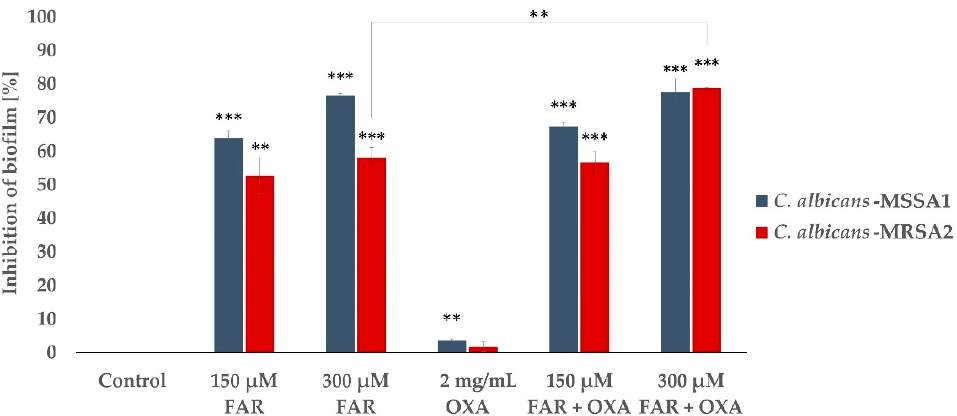
Figure 3. Inhibitory effect of FAR (150 and 300 µ M) in combination with OXA (2 mg/mL) on mixed biofilms formed by C. albicans -MSSA1 and C. albicans -MRSA2 using the XTT assay. Optical density (OD 490 ) of suspension was determined after 48 h cultivation of biofilms in the presence of different concentrations of FAR; the control sample was without FAR. Percentage of growth inhibition was calculated from the OD 490 values of samples compared to the inhibition of the control sample set to 0%. Data represent the average of 3 independent experiments performed in triplicate. A p < 0.01 (**) was considered statistically highly significant; p < 0.001 (***) was considered extremely